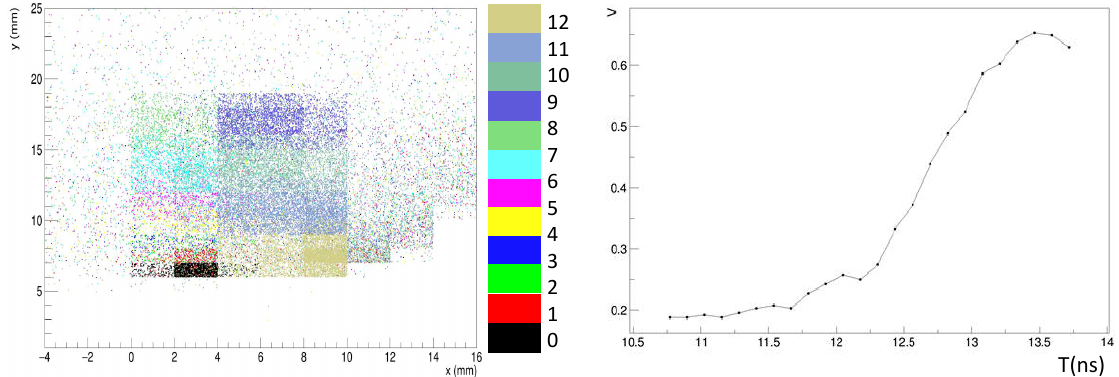
Figure 6. ( On the left ) the tomography of one of the sensors done with the Silicon strip detector. ( On the right ) an example of a non calibrated waveform collected during the data